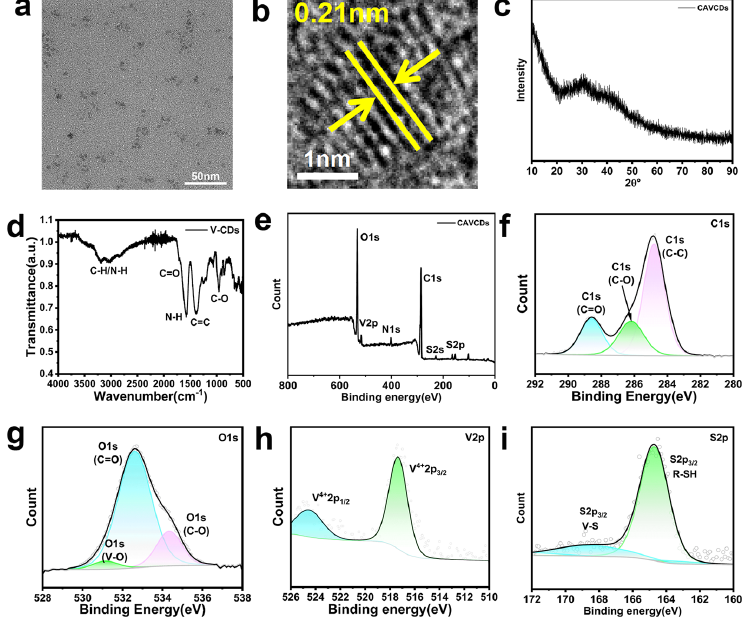
Figure 1. ( a ) TEM image of V − CDs. ( b ) HRTEM image of V − CDs. ( c ) XRD pattern of V − CDs. ( d ) FTIR spectra of V − CDs. ( e ) XPS survey spectra of V − CDs. The high resolution XPS spectrum of V − CDs: ( f ) C1s, ( g ) O1s, ( h ) V2p, and ( i ) S2p, respectively.